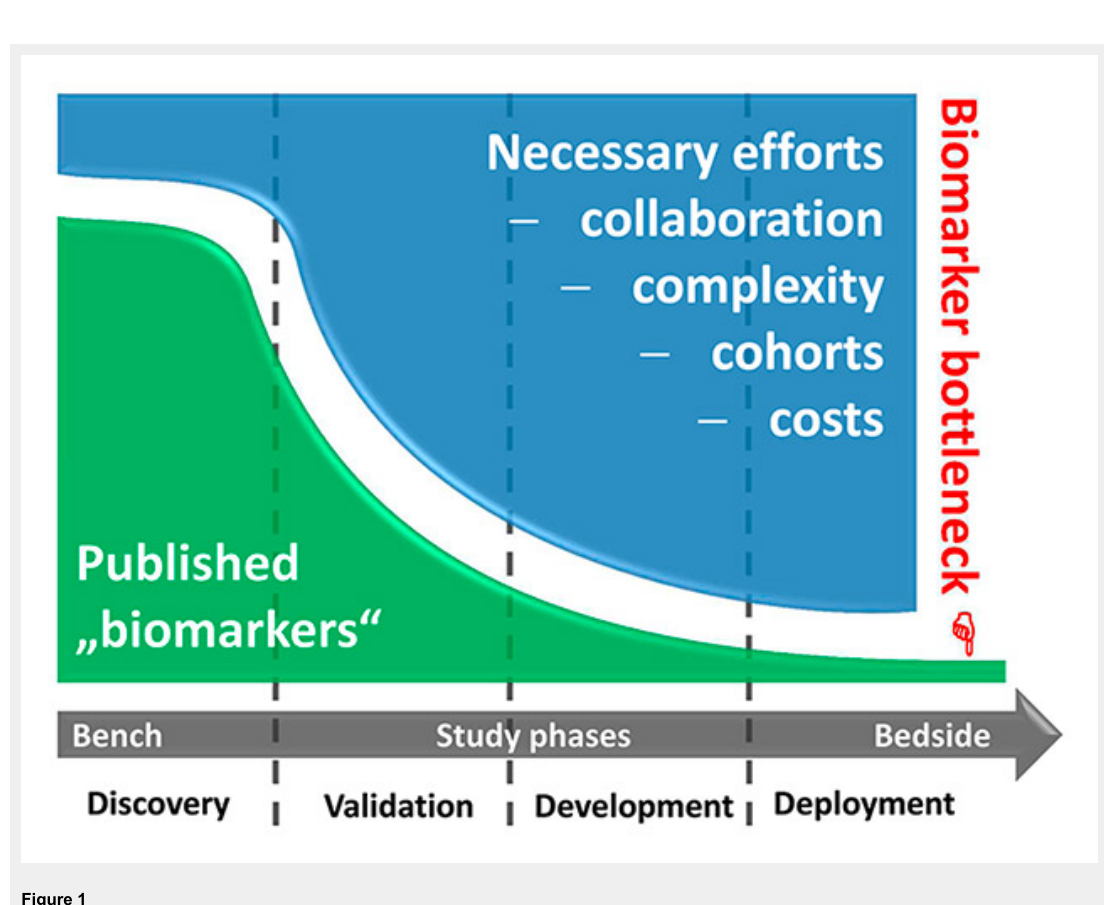
The biomarker bottleneck. During the successive phases of the transition of a biomarker from bench to bedside (roughly segmented into exploratory “discovery”, multicentred “validation”, clinical assay “development”, and large-scale “deployment” phases), the hurdles for successful evolution are steeply increasing. Researchers face exploding costs and complex regulatory requirements, and they have to cooperate with competing groups to gain large and independent validation cohorts. Finally, few – if any – markers can be clinically